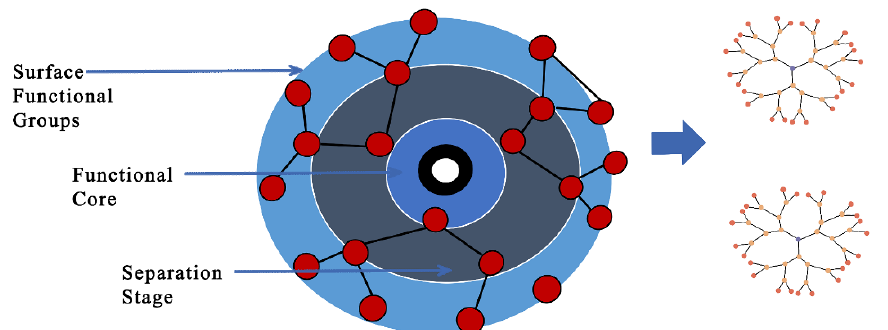
Figure 5. Illustration of dendritic molecular structures with a central core, repeating branches, and terminal reactive functional groups. They can be classified as polymers and hyperbranched polymers with convergent and divergent architectures, depending on their molecular nature weight. Their nanostructure provides dendrimer–drug conjugation via different interactions such as electrostatic and hydrophobic/hydrogen bonds or the capacity for drug encapsulation within the central cavity and/or between the dendrons (branches). Adapted and modified from [87] under the Creative Commons license.